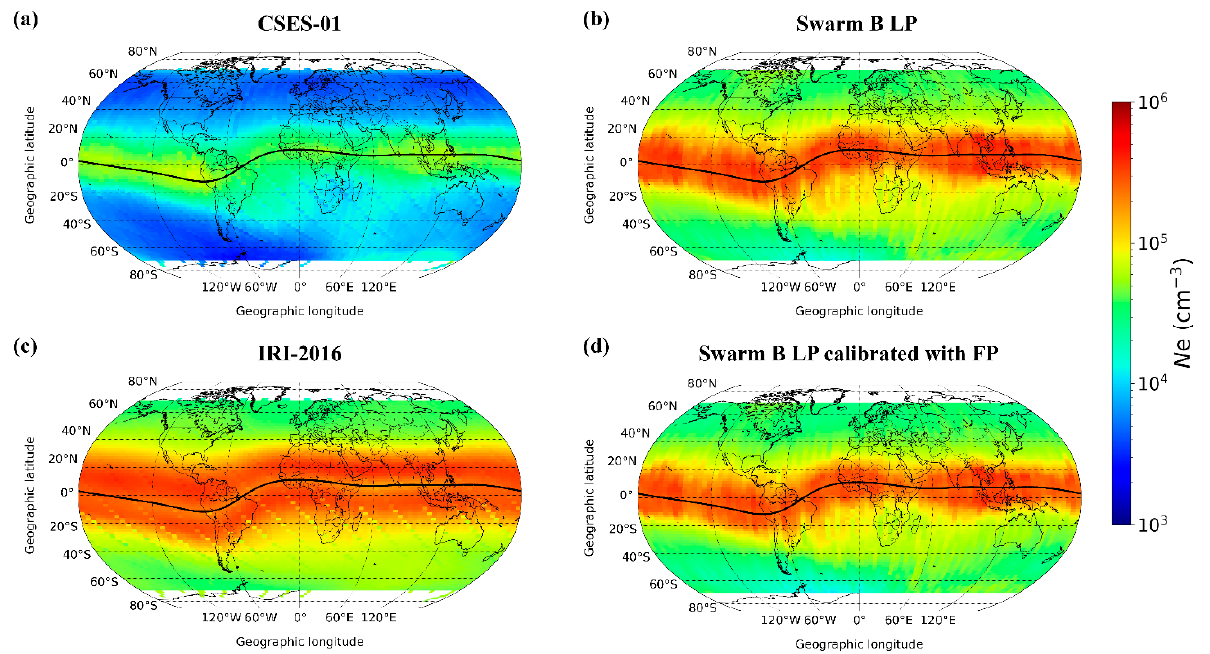
Figure 3. Geographical maps of N e mean values measured by CSES-01 LP (Panel ( a )), Swarm B LP (Panel ( b )), and Swarm B LP after applying the calibration with FP observations (Panel ( d )) and modelled by IRI-2016 along CSES-01 orbits (Panel ( c )) for the daytime sector (13:00 − 15:00 LT). The mean is calculated on data ranging between 1 January 2019 and 30 September 2021. The thick black curve in each plot represents the geomagnetic equator.